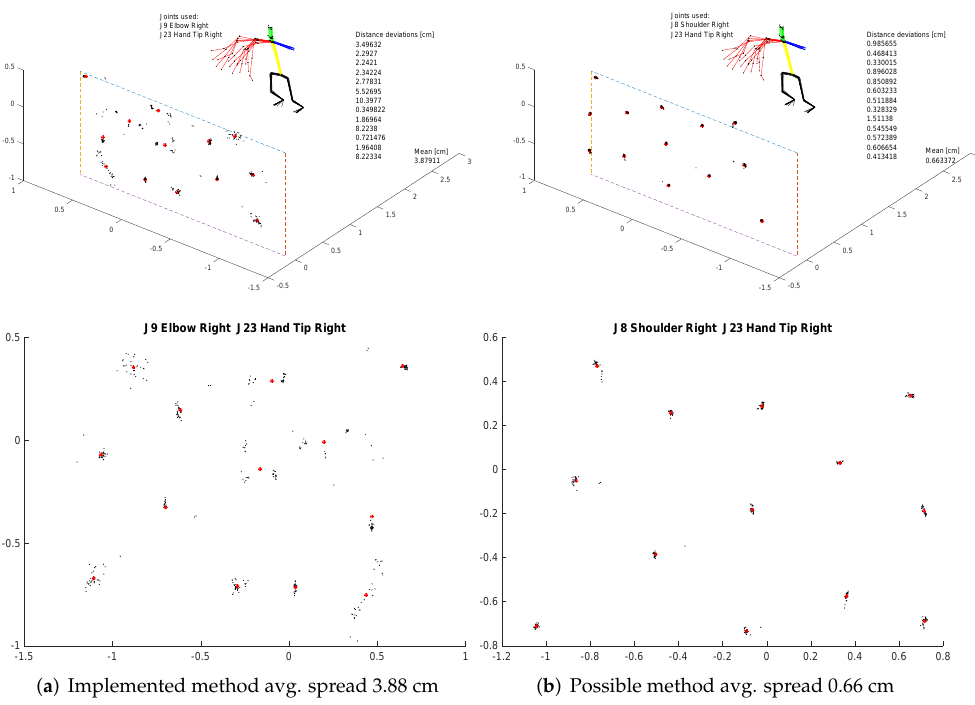
Figure 18. Evaluation of the spread of the resulting Points of Interest (POIs) at a 2.5-m distance. Calculated mean positions are depicted as red circle